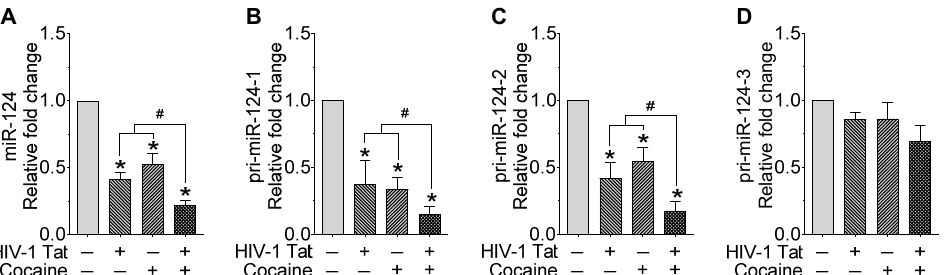
Figure 1. HIV-1 Tat and cocaine significantly decreased the miR-124 levels in mouse primary microglial cells. Representative qPCR analysis showing the expression of mature miR-124 ( A ), pri-miR-124-1 ( B ), pri-miR-124-2 ( C ), and pri-miR-124-3 ( D ) in HIV-1 Tat- (25 ng/mL) and cocaine (10 µ M)-exposed mouse primary microglial cells for 24 h. Data are mean ± SEM from six independent experiments. Nonparametric Kruskal–Wallis one-way ANOVA followed by Dunn’s post hoc test was used to determine the statistical significance of multiple groups. * p < 0.05 versus control; # p < 0.05 versus HIV-1 Tat or